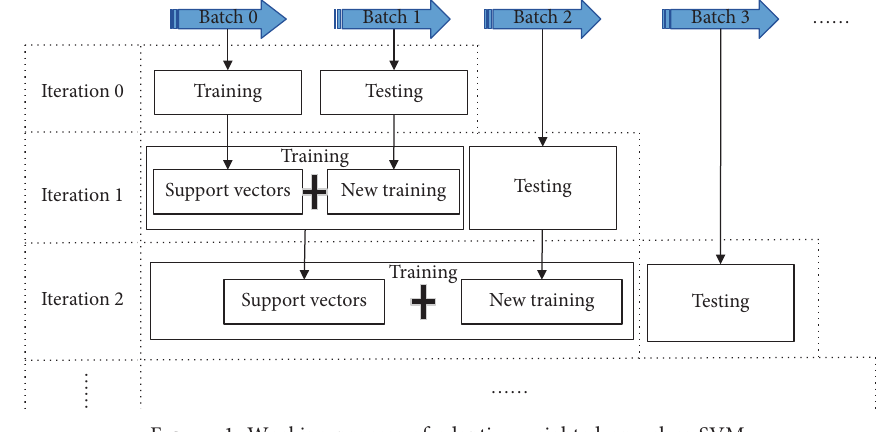
Figure 1: Working process of adaptive weighted one-class